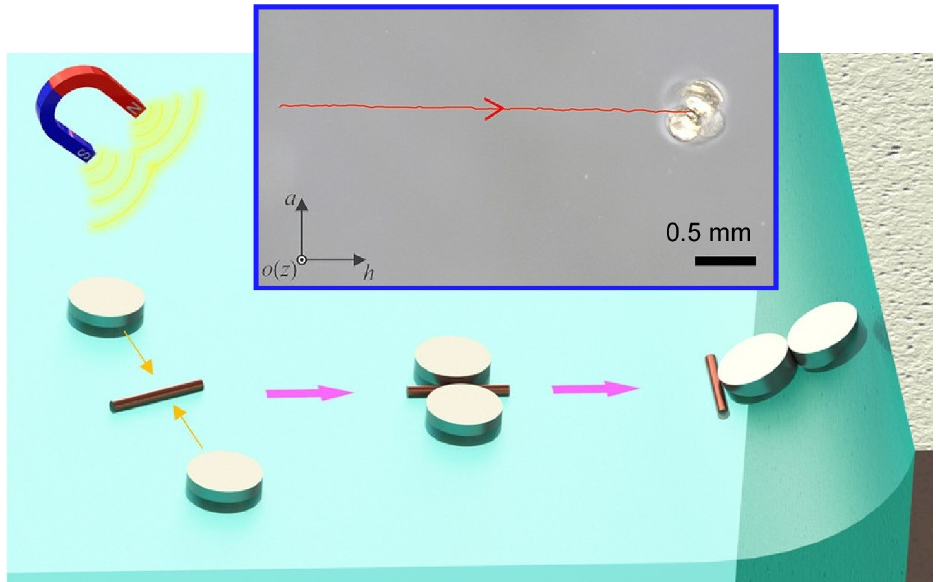
Figure 27. A pair of magnetic microdiscs as partners with flexible motion and in situ micromanipulation on an ethylene glycol surface controlled by adjusting the direction of the applied magnetic field. Reprinted with permission from Reference [206]. Copyright 2022 American Chemical Society.